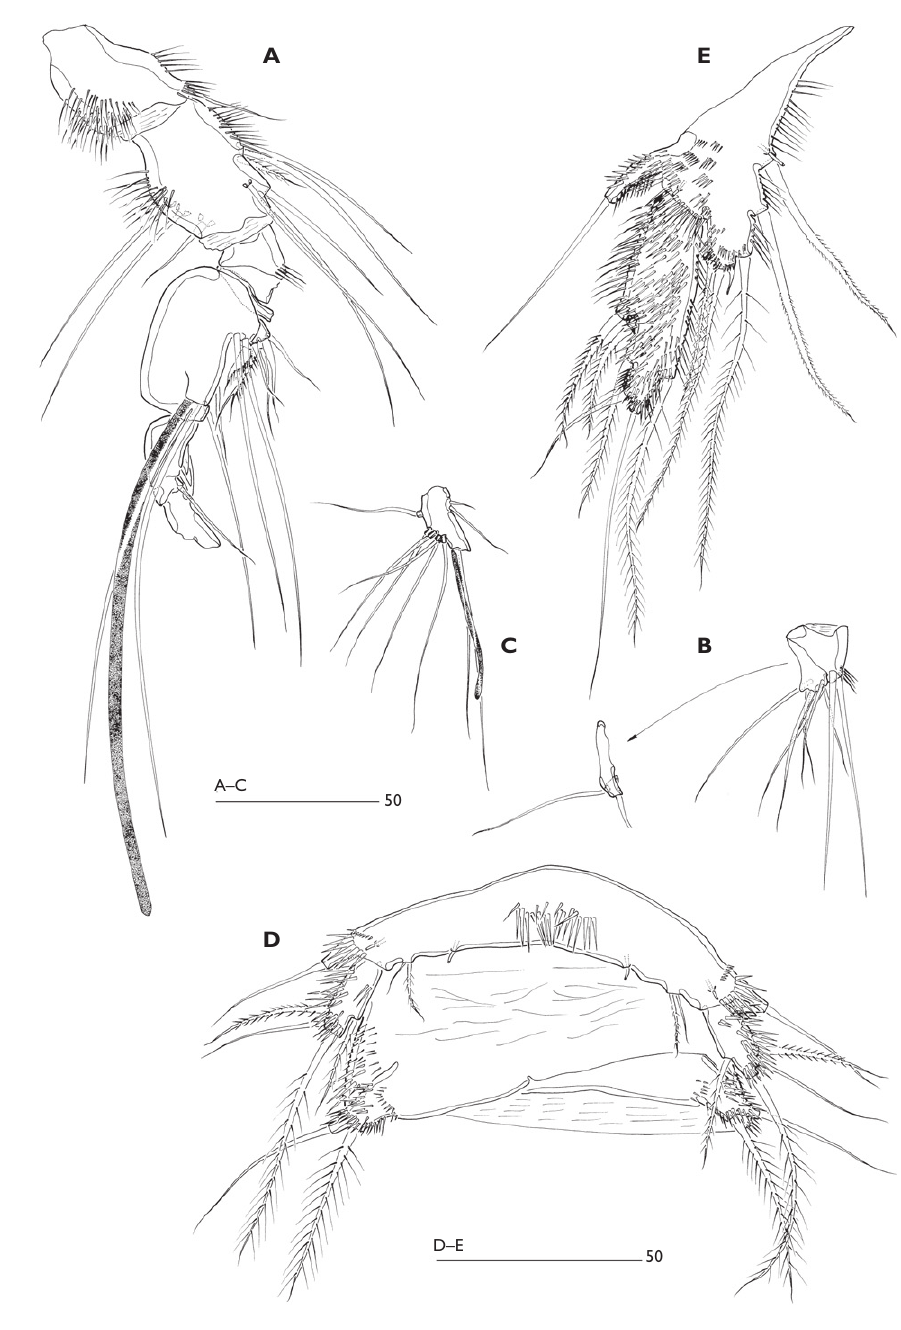
Figure 6. Marbefi a carthyi (Hamond, 1968), comb. n.: A antennule ♂ , ventral [armature on segments 3, 4 and 8 omitted] B antennulary segments 3 (right) and 4 (left) ♂ C antennulary segment 8 ♂ D P5 and P6 ♂ , anterior E P5 ♀ ,